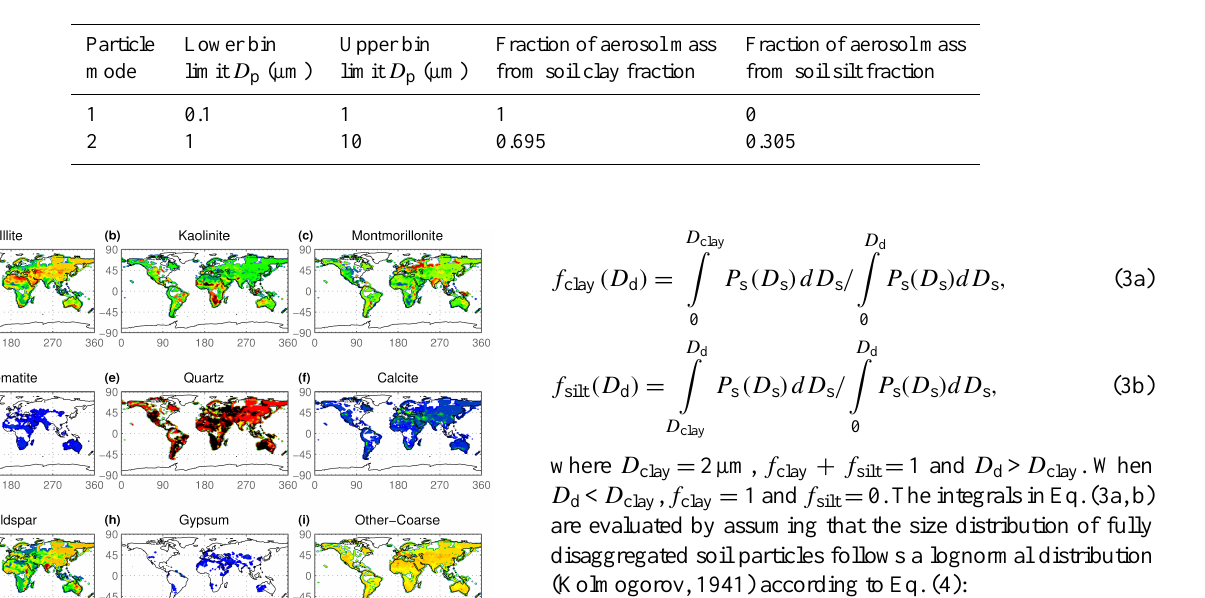
Table 2b. The fraction of dust aerosol mass contributed by the soil clay and silt fractions for each of the two particle modes for the modal aerosol scheme in CAM5 from work by Kok (2011).